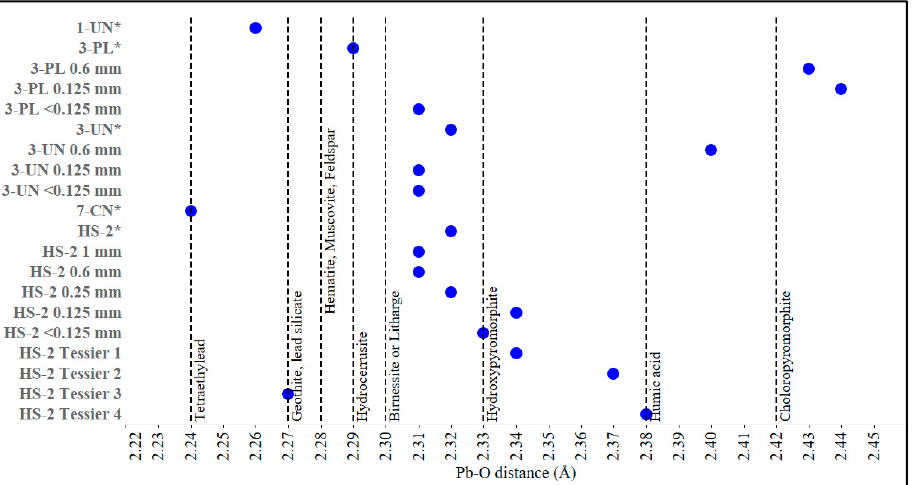
Figure 5. First-shell Pb-O distances of samples as determined by X-ray absorption fine structure spectroscopy (XAFS) analysis (y-axis, blue circle) plotted against Pb-O distances of Pb minerals and Pb-mineral sorption complexes (x-axis) as reported in the literature Table S9. Samples marked with an asterisk (*) are the <2 mm sieved particle size fraction prior to Tessier sequential extraction and sieving to 1 to <0.125 mm particle size.